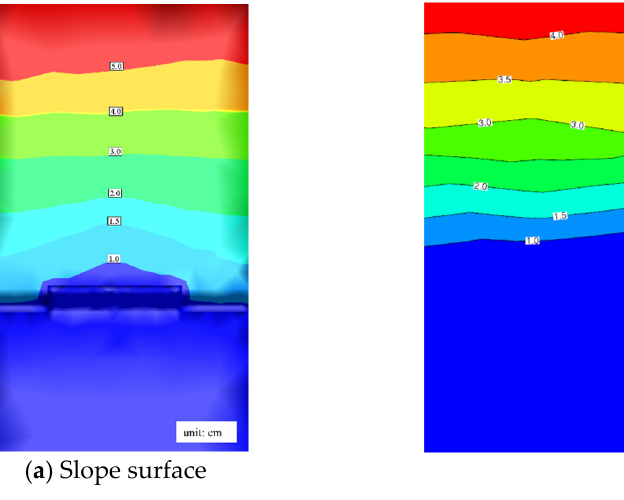
Figure 13. Deformation contour of slope surface and vertical section calculated by the numerical simulation.